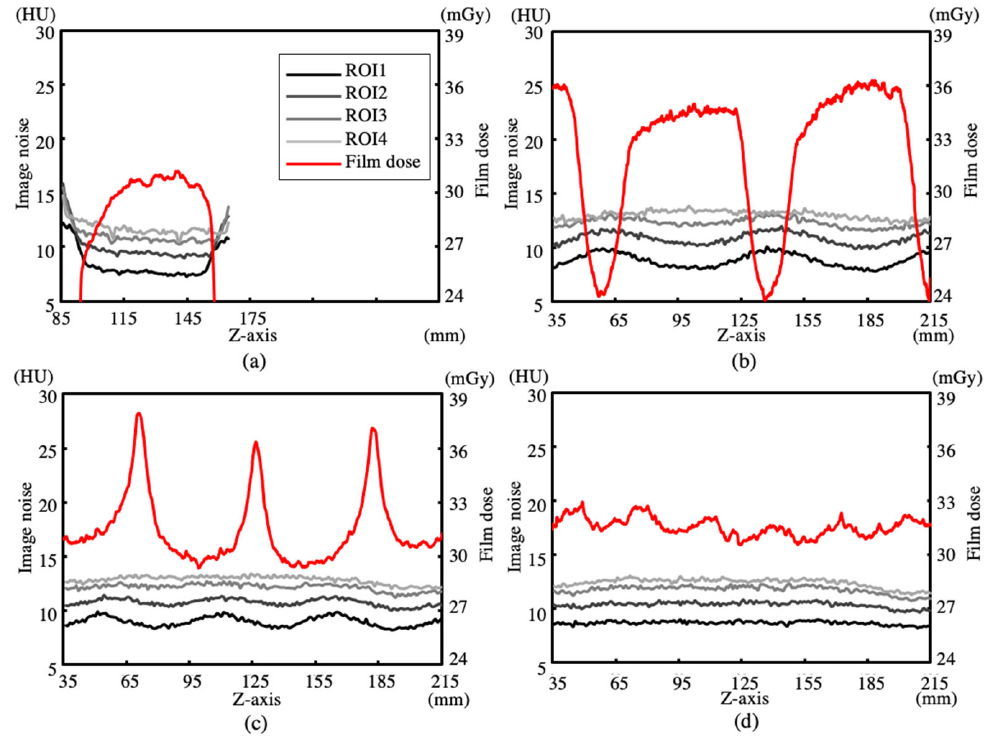
Figure 4. Dose (z) and Noise (x, y, z) for ROI1, ROI2, ROI3, and ROI4 in IMR images. ( a ) Axial scan. Helical scans with pitch values of ( b ) 0.992, ( c ) 0.696, and ( d ) 0.399.